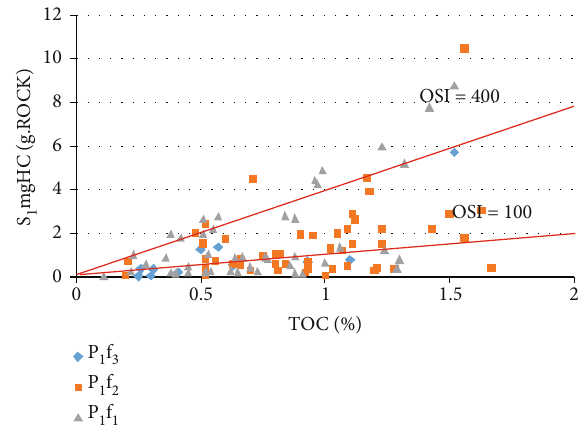
Figure 11: Oil saturation characteristics of the Fengcheng Formation shale in the Mahu Sag.